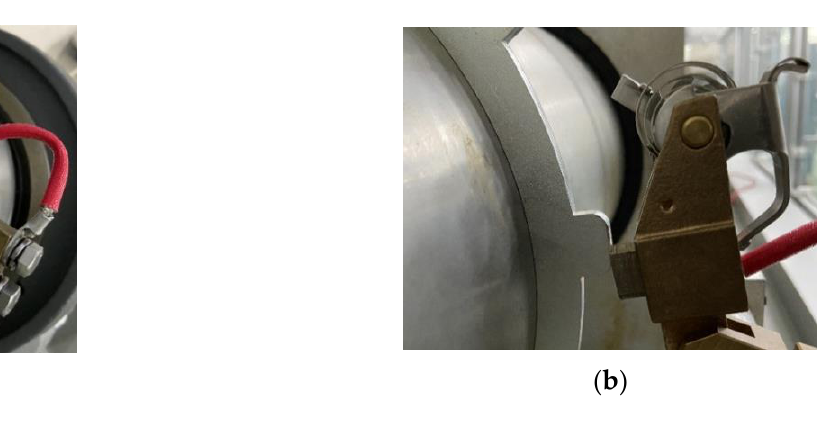
Figure 5. Photo of the experimental setup for electrical pitting prevention device.